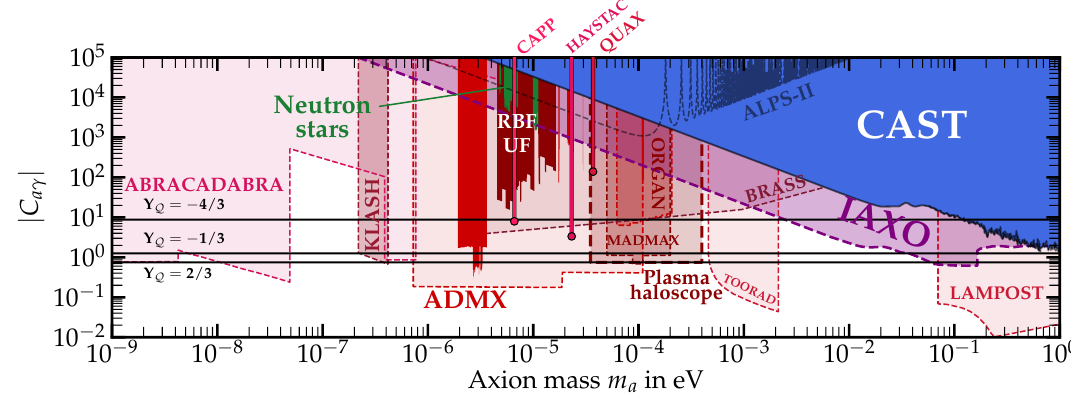
Figure 2 . Predictions for the axion-photon coupling in eq. (3.9) and sensitivity of present and future axion experiments. Axion limits from